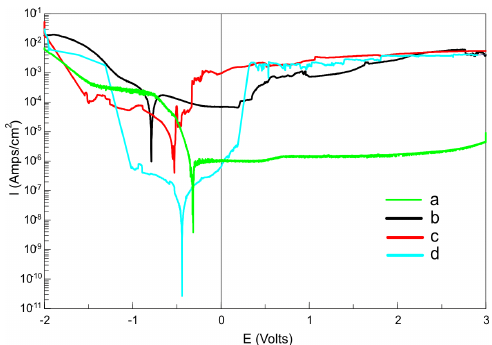
Figure 6. Potentiodynamic polarization curves of microcrystalline Ti ( a ); Ti23Mo 3BG nanocomposites before ( b ) and after electrochemical etching ( c ) as well as after additional Ca-P deposition ( d ) in Ringer’s solution at 37 ˝